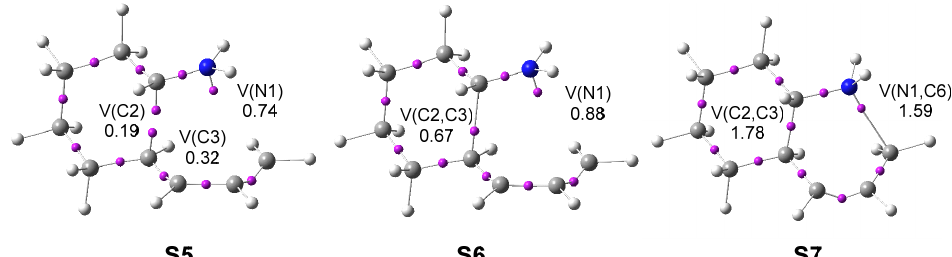
Figure 6. ELF basin attractor positions, with the most significant valence basin populations, in average number of e, of the structures S5 – S6 involved in the formation of the new N1 − C6 and C2 − C3 single bonds along the re/exo reaction path of the IIDA reaction of dieniminium 16 . The topology of the ELF of structure S5 , d(N1-C6) = 2.840 and d(C2-C3) = 2.055 Å, shows the presence of a V(N1) monosynaptic basin, integrating 0.74 e, and two monosynap- tic basins, V(C2) and V(C3), integrating 0.19 and 0.32 e, respectively. These monosynaptic basins, which are not present in dieniminium 16 , are created along the reaction path. While the V(N1) monosynaptic basin, resulting of the strong depopulation of the N1 − C2 bonding region and the intramolecular GEDT taking place in this IIDA reaction, is demanded for the formation of the N1 − C6 single bond, the V(C2) and V(C3) monosynaptic basins are needed for the subsequent formation of the first C2 − C3 single bond. At S5 , the GEDT is 0.40